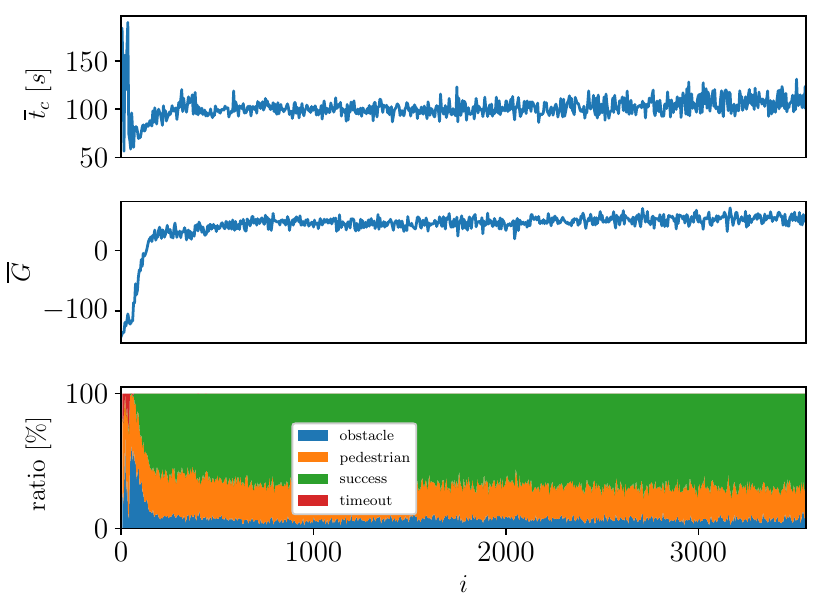
Figure 10. Summary of the DQL performance: in the top row, the evolution of the average of the duration of the single simulation run t c ; in the middle row, the evolution of the average of the cumulative reward G ; in the bottom row, the evolution of the statistic of the simulation termination reason